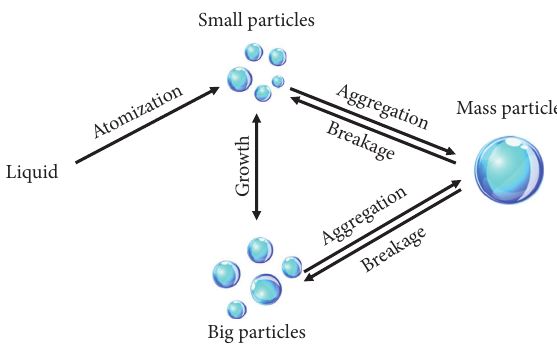
Figure 1: Schematic of dynamic evaluation of